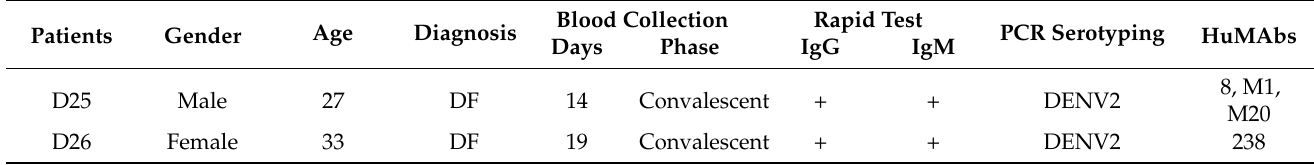
Table 1. Summary of patients’s backgrounds and HuMAbs used in this